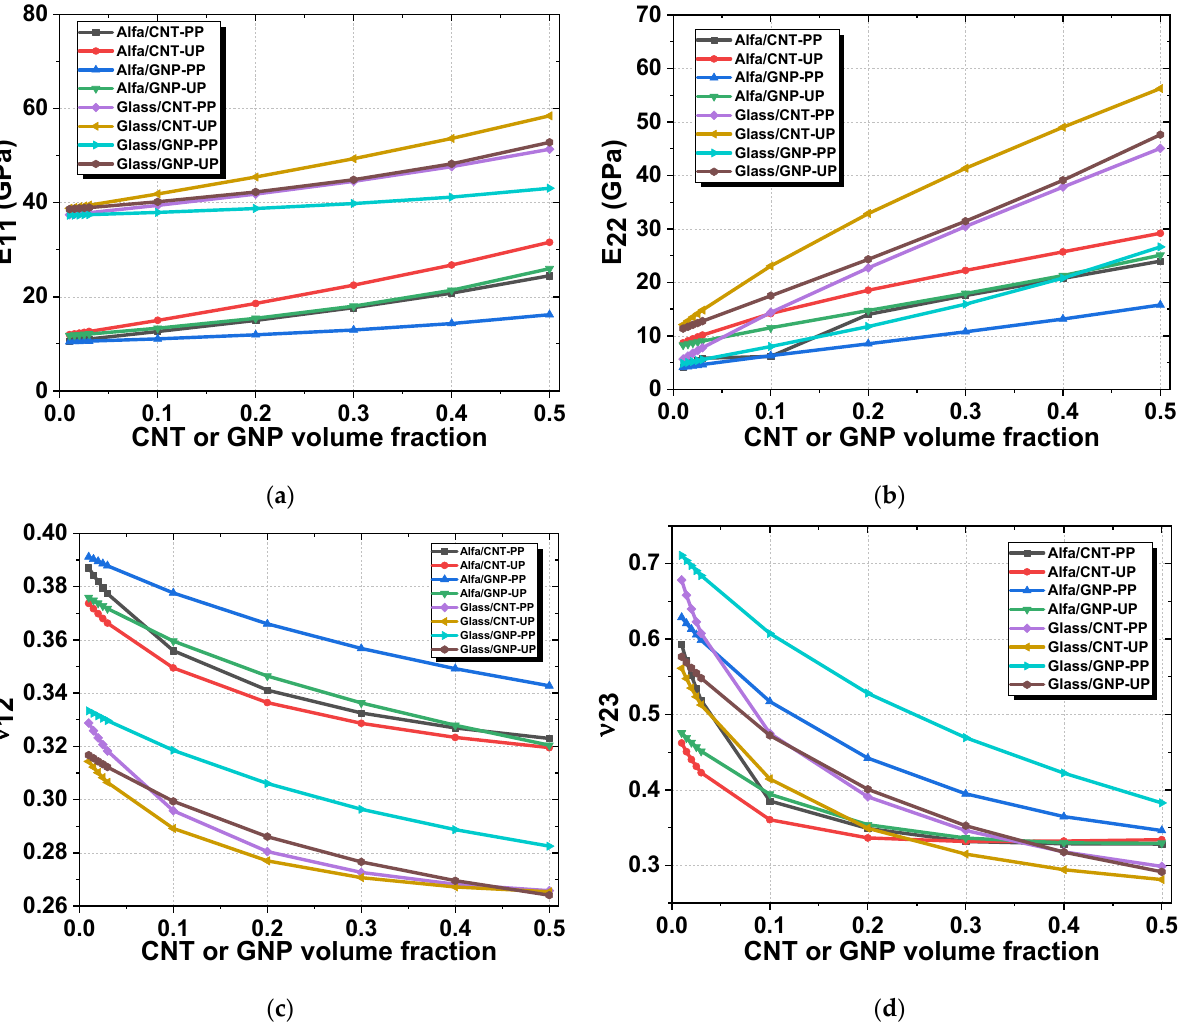
Figure 13. Comparison of the transverse elastic moduli of an effective matrix reinforced by aligned alfa and E-glass fibers vs. nanofiller volume fraction by Digimat-MF. ( a ) E 11 axial Young’s modulus. ( b ) E 22 in-plane Young’s modulus. ( c ) v 12 transverse Poisson’s ratio. ( d ) v 23 in-plane Poisson’s